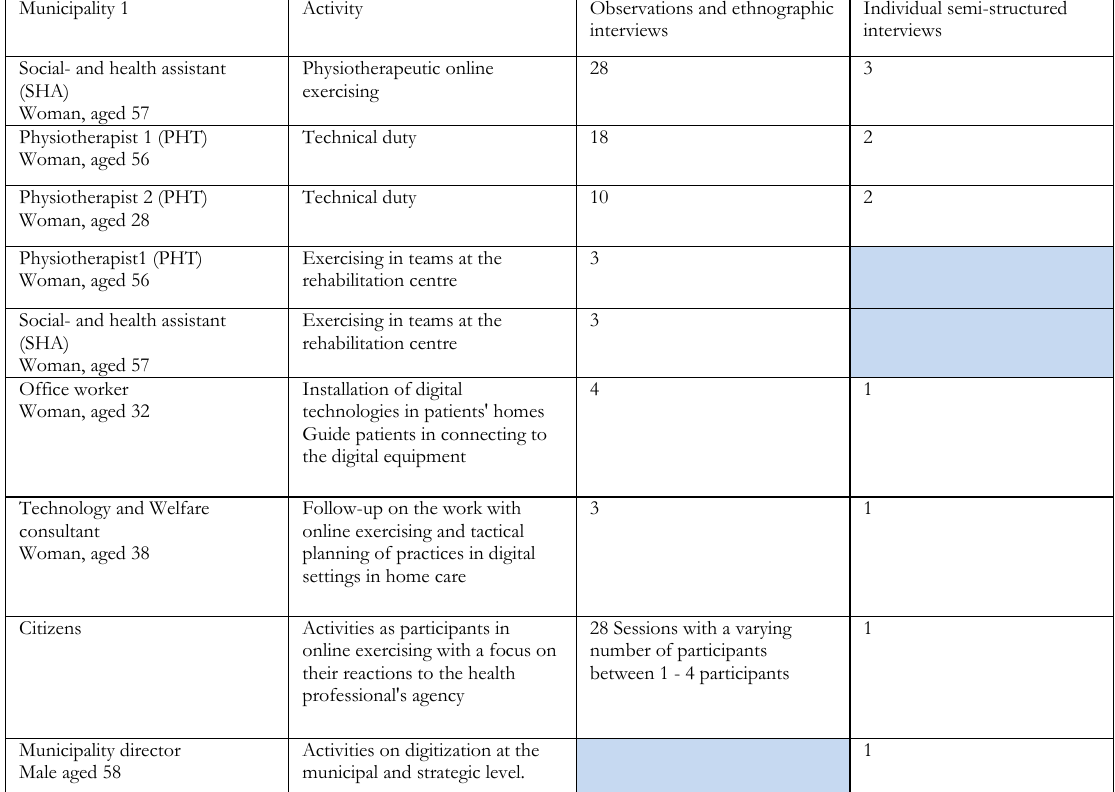
Table 1. Overview of empirical material produced through 18 months of